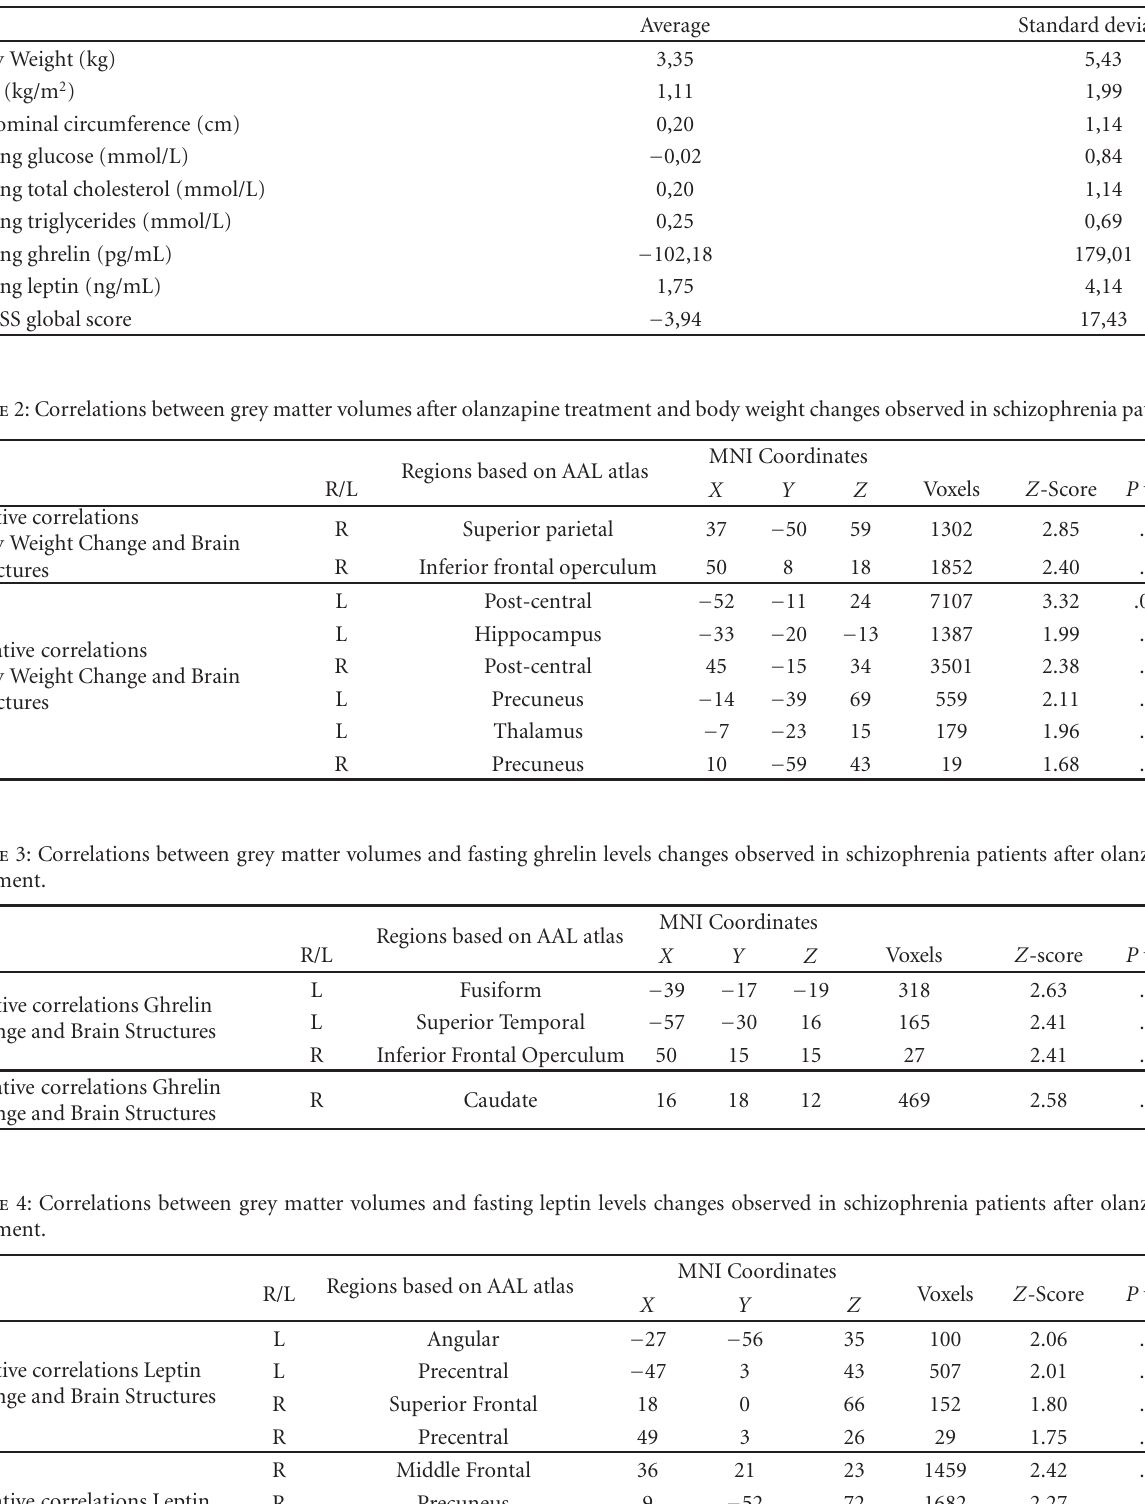
Table 1: Biometrical, metabolic, and clinical variations during the study.